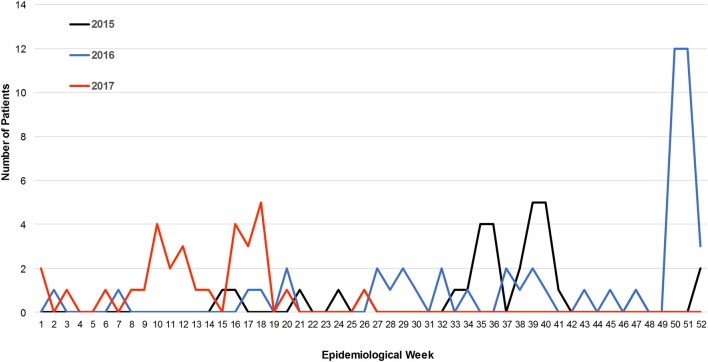
Incidence of CHIKV infections over a 27 month period. The number of IgM positive patients of CHIKV is plotted against epidemiological week.